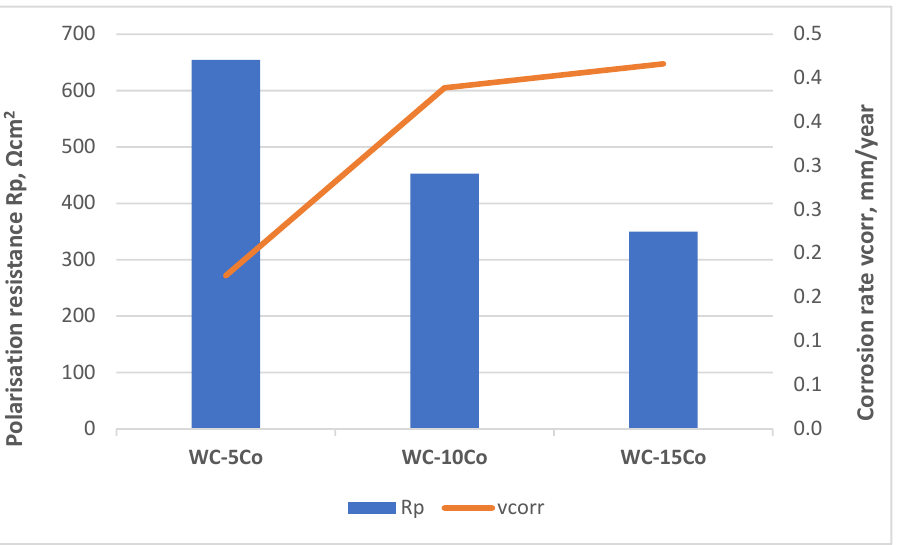
Figure 7. The dependence of R p and v corr concerning Co content.